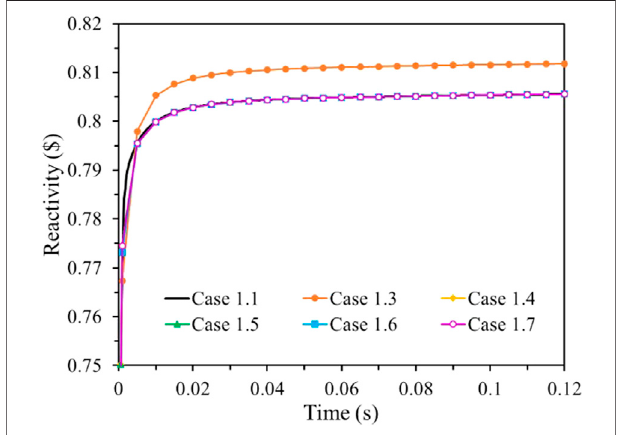
FIGURE 5 | Reactivity history for heterogeneous UO 2 assembly